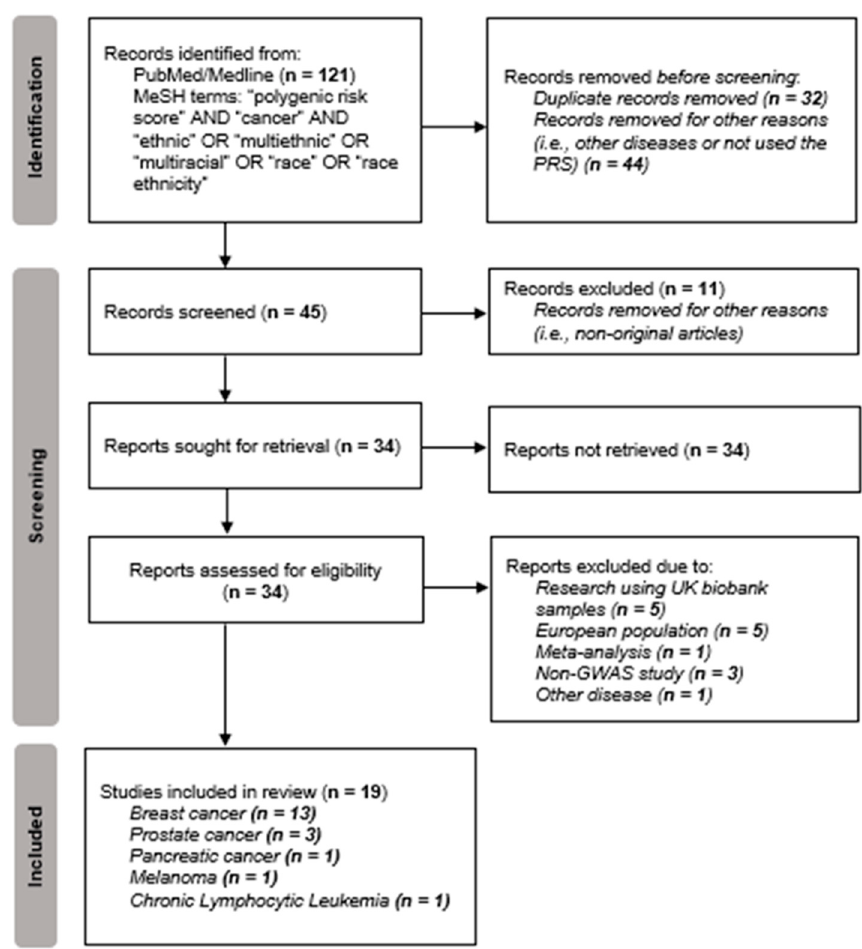
Figure 2. Flowchart of data obtained from the search of PUBMED/Medline records based on the PRISMA methodology [30].